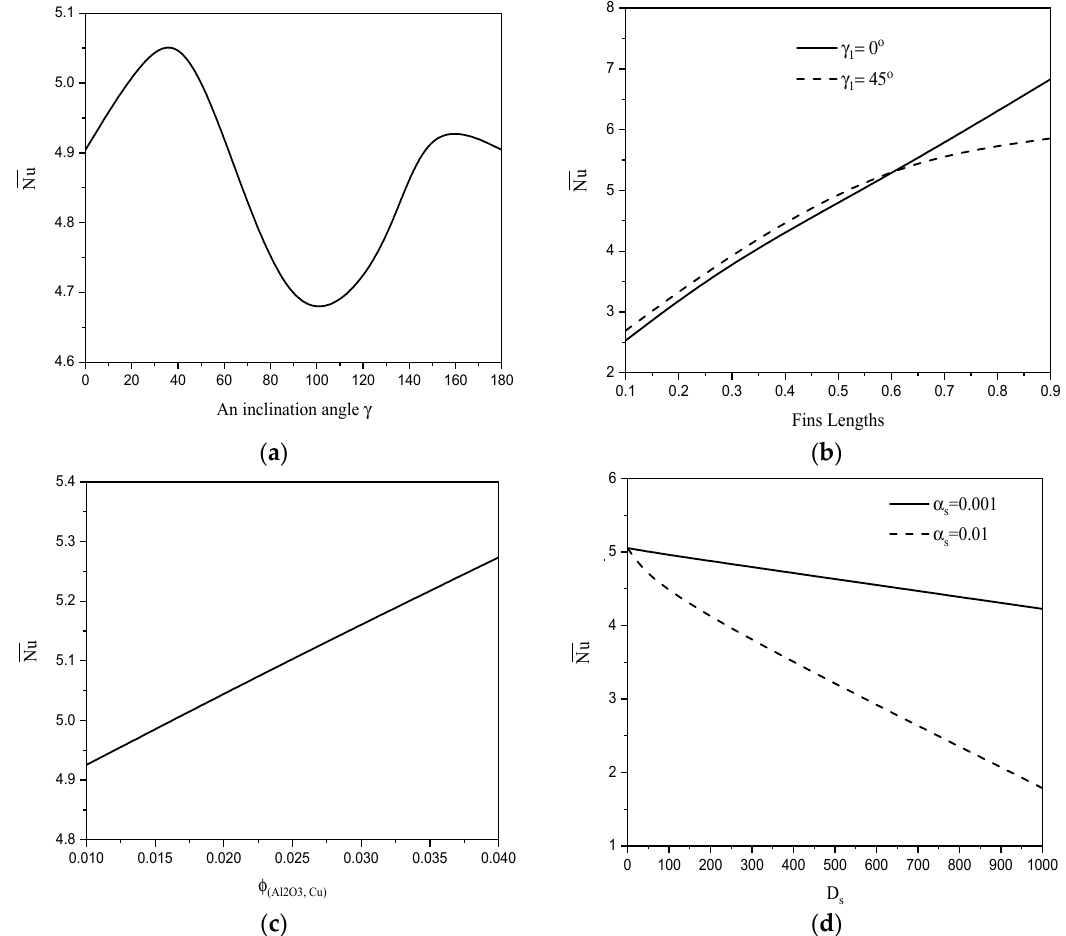
Figure 15. Average Nusselt number under the effects of ( a ) an inclination angle, ( b ) fins lengths with two values of an inclination angle, ( c ) solid volume fraction for hybrid nanofluid, and ( d ) mixture densities ratio with two values of dusty parameter, at 𝑅𝑎 = 10 (cid:2873) and 𝛾 = 0.1 .